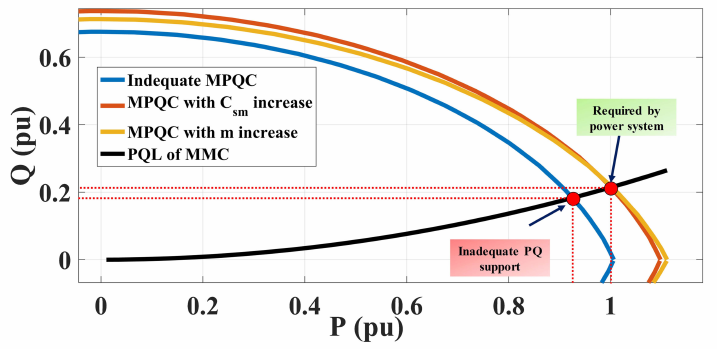
Figure 5. An adequate MMC design for satisfying grid requirement by increasing capacitance to 4.91 mH or modulation index to